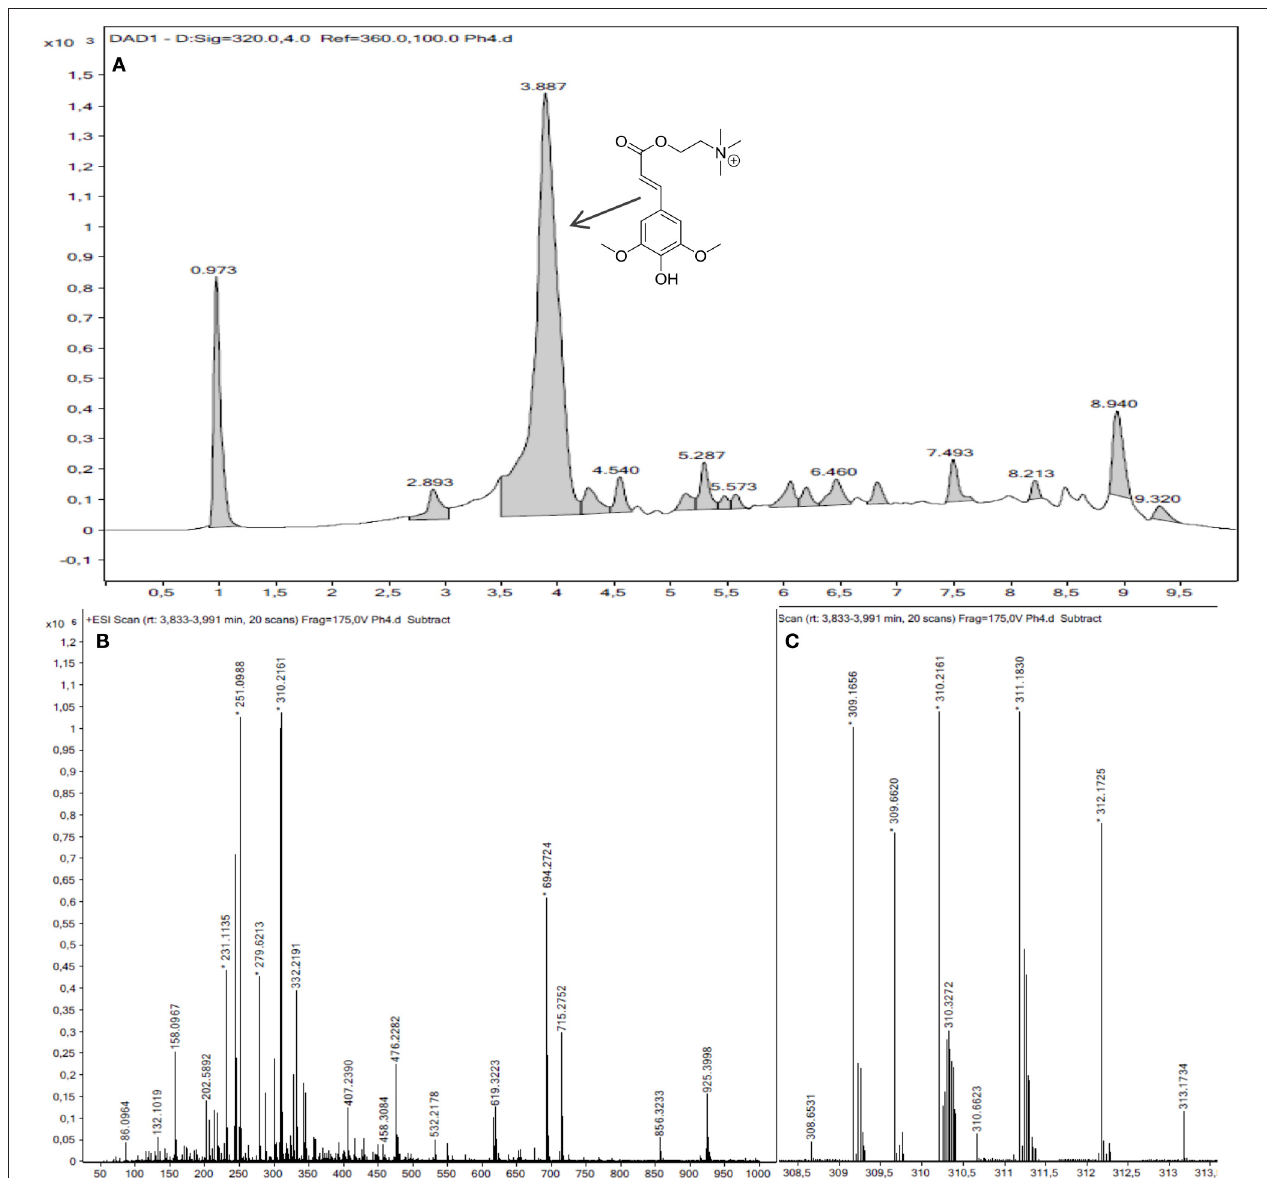
FIGURE 3 | (A) Chromatogram at 320nm of mustard bran extract; (B) Ionic spectrum of the major compound (Sinapine, t r = 3.89min); (C) Zoom on isotopic